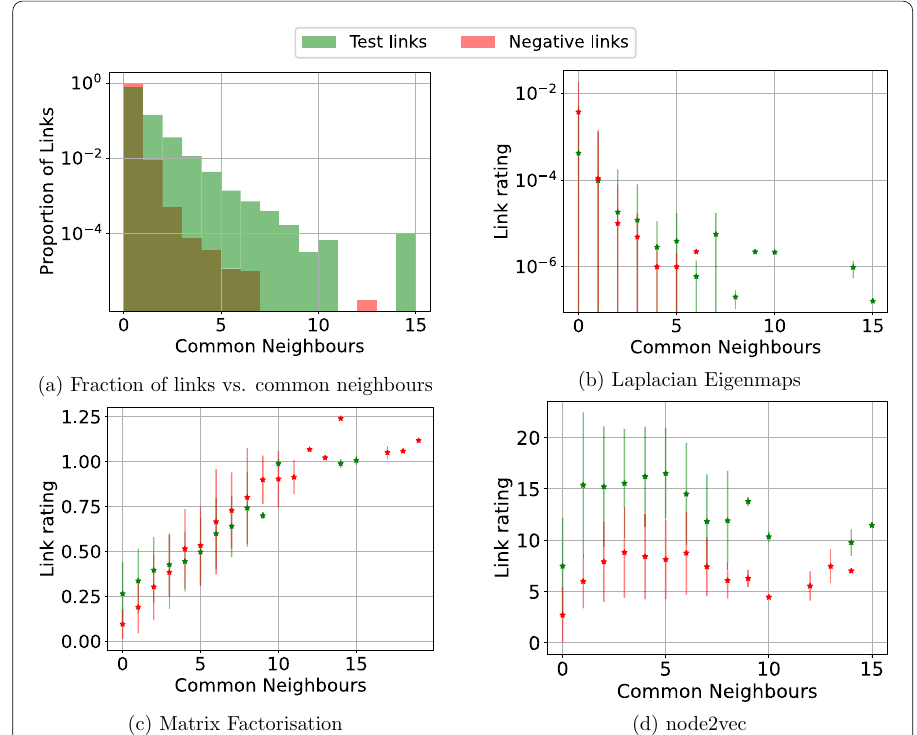
Fig. 5 a Fraction of links of the Maayan‑Vidal network (original) that share a given number of neighbours. Average rating of negative and test links with a given number of common neighbours derived by b Laplacian Eigenmaps, c Matrix Factorisation, and d